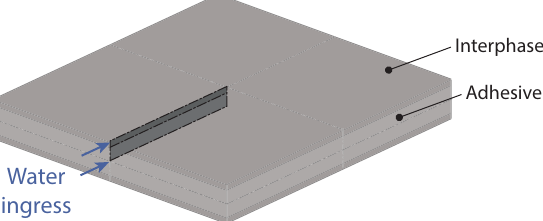
Figure 9. Numerical model developed to understand the water uptake of the interphase.